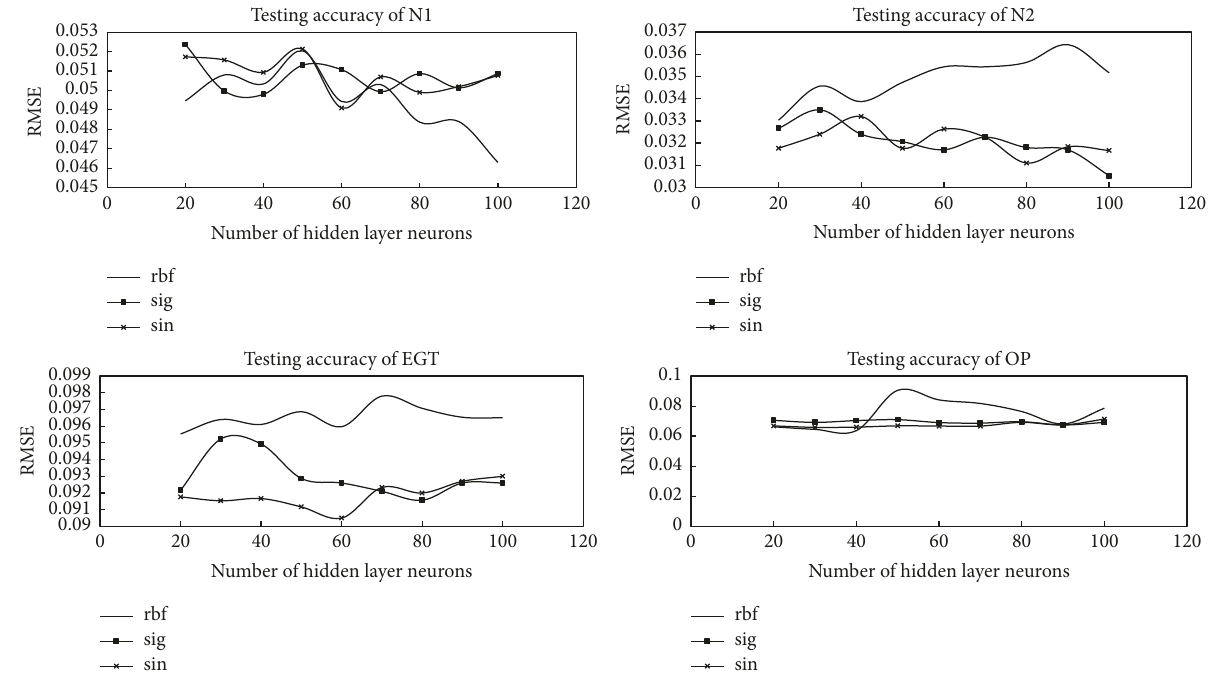
Figure 3: Testing accuracy with different activation